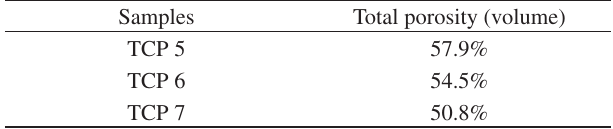
Table 1. Total porosity values of foams obtained by mercury porosimetry technique.